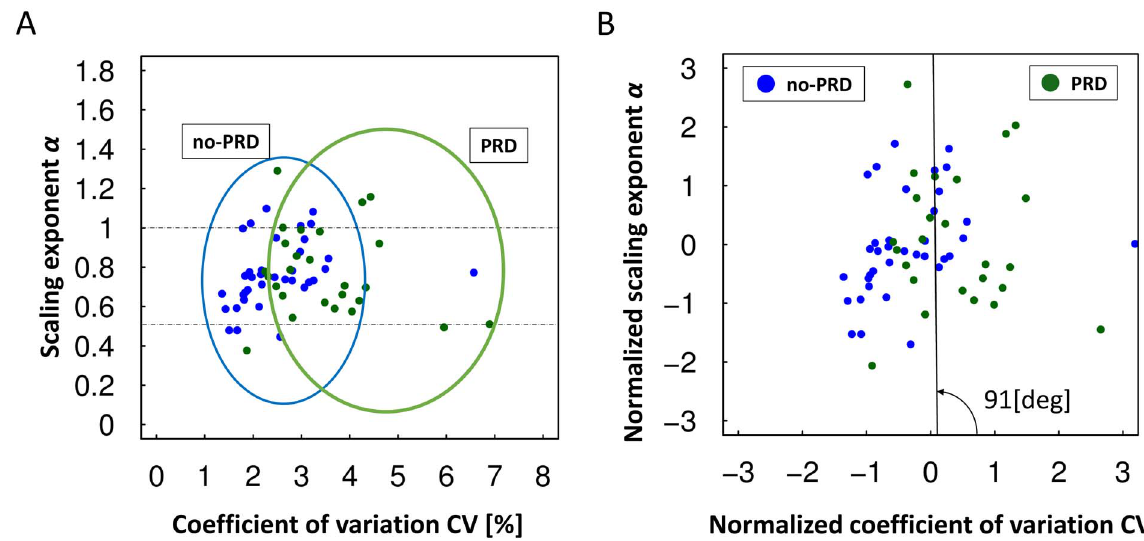
Figure 3. Classification according to the presence or absence of postural reflex disorder. The no postural reflex disorder group (no-PRD) is indicated by blue points, and the postural reflex disorder group (PRD) is indicated by green points. The x-axis represents the CV, and the y-axis represents a . The data for the no-PRD group are distributed in a small CV region around 2%, whereas those for the PRD group are distributed in a large CV region roughly from 2.5% to 5%. The two groups have a wide and overlapping distribution of a . (A) Distribution of the original data. (B) Distribution of the normalized data. The solid line represents the boundary between the no-PRD group and the PRD group. doi:10.1371/journal.pone.0112952.g003 sensitivity was 80%, and the specificity was 55%. The solid line represents the boundary line between the two groups, and the dashed line represents a horizontal line that corresponds to the average level of the original value of a . The angle between the normalized CV axis and the boundary line shown in Figure 4B was 5.7 u . The small angle observed between the normalized CV axis and the boundary line suggests that a can be used to differentiate obvious-PRD from mild-PRD.